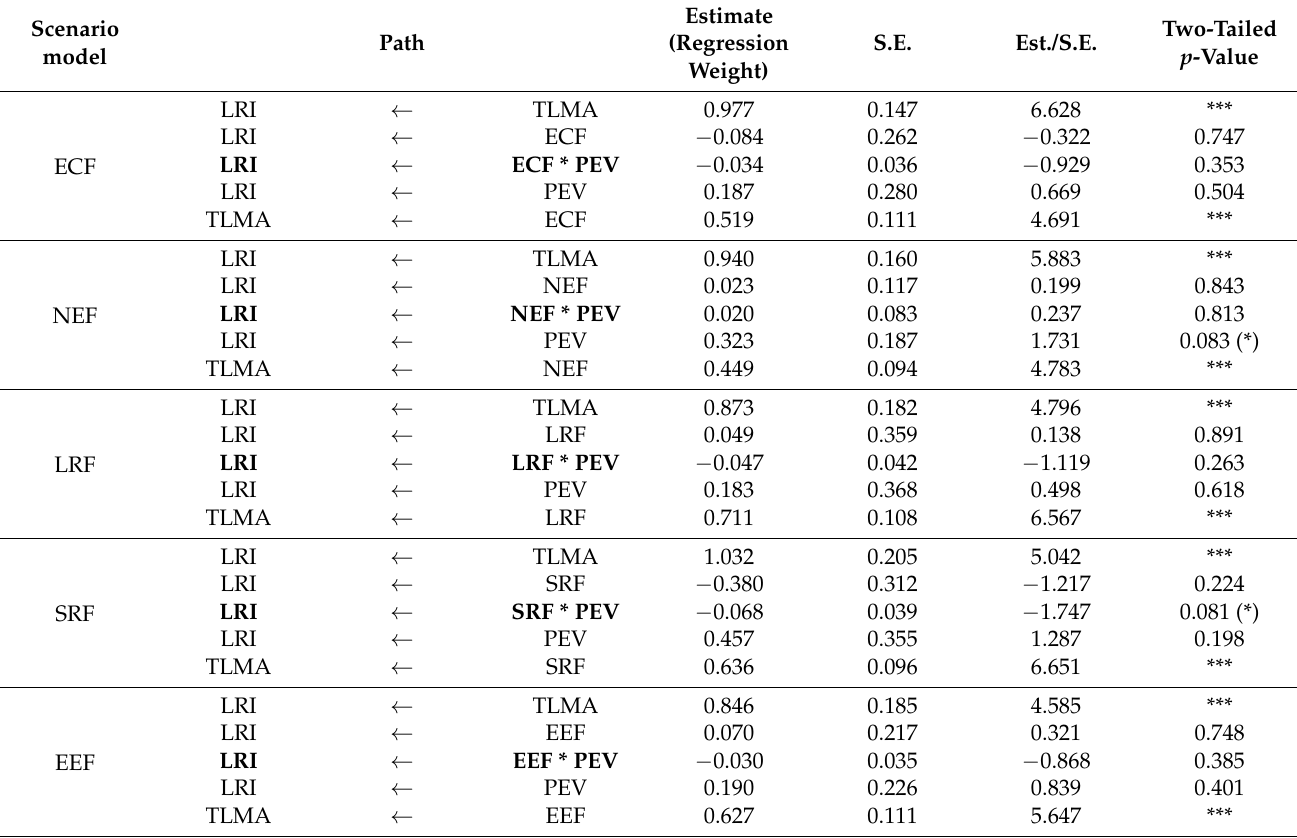
Table 5. Path coefficient and significance of PEV moderating effect